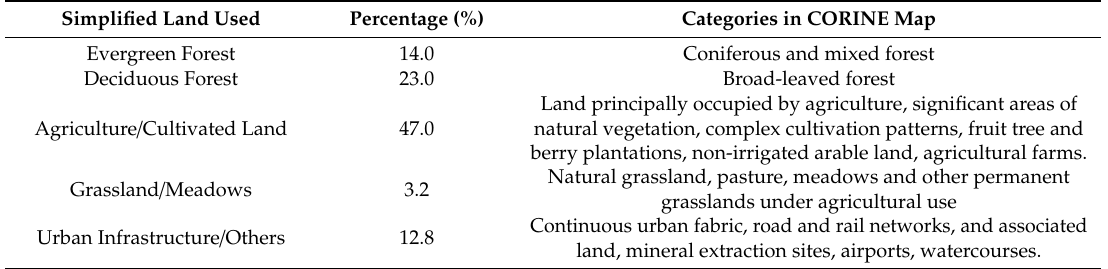
Table 2. Overview of simplified land uses derived from the CORINE map applying for Saxony.